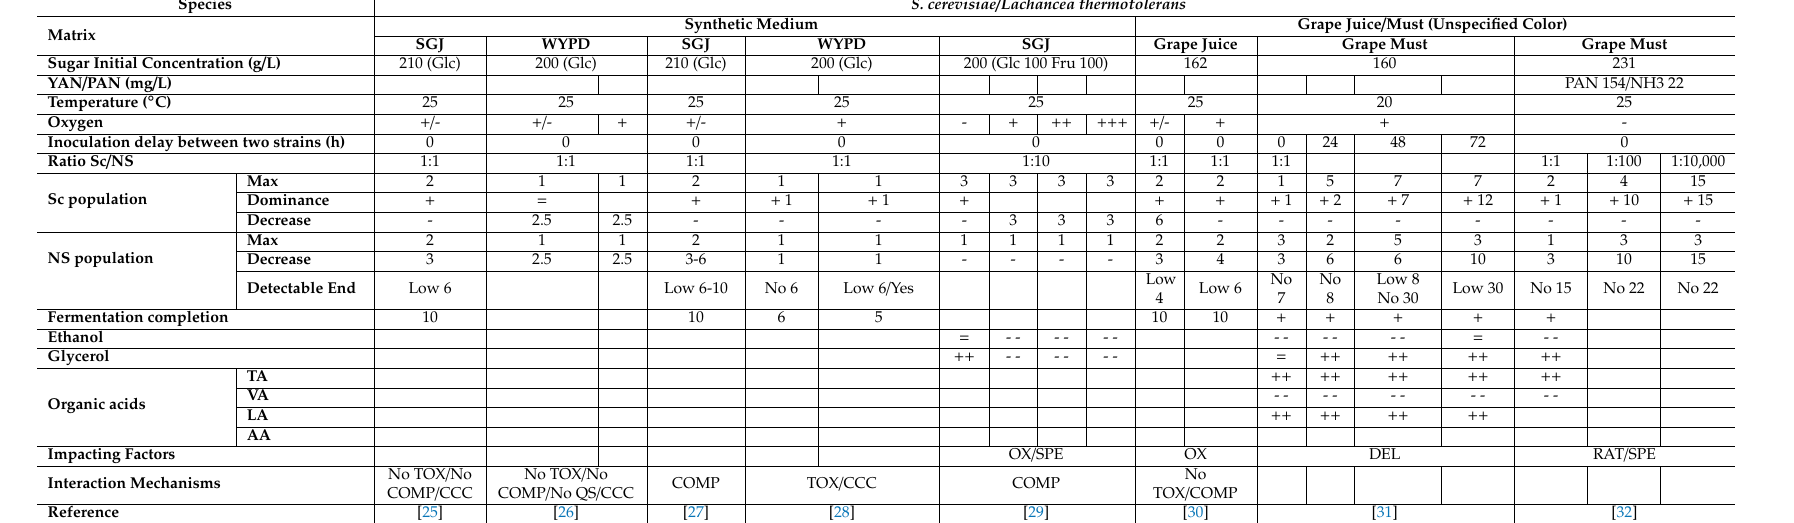
Table 1. Diversity of methodologies and results in S. cerevisiae / Lachancea thermotolerans interaction experiments.